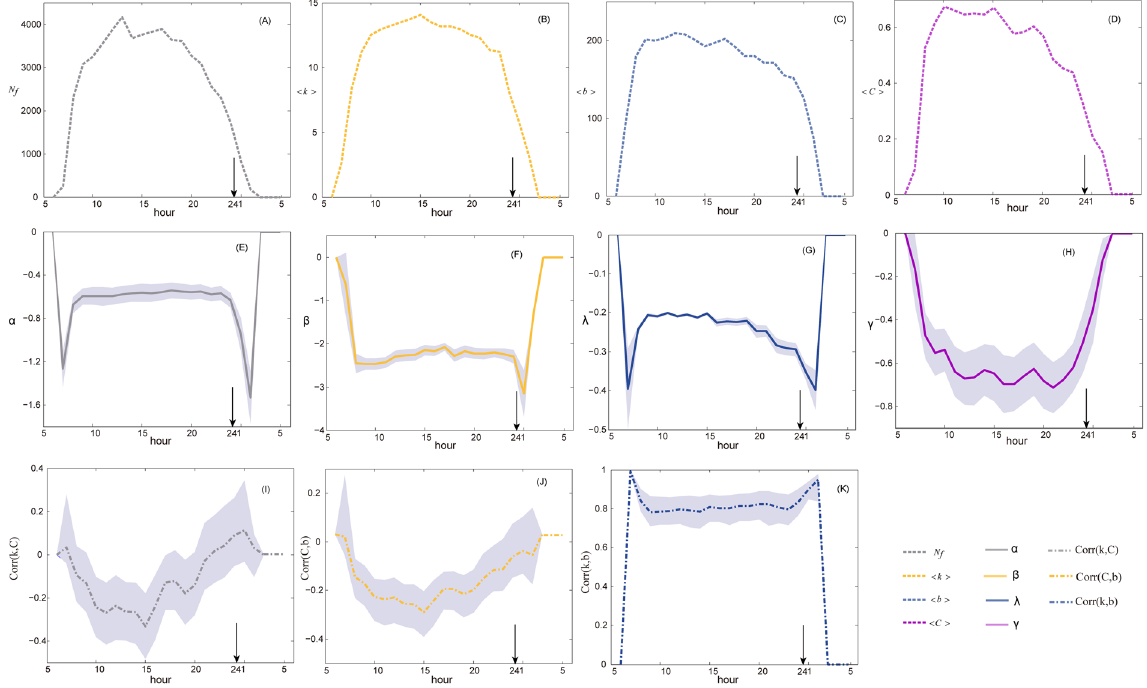
Figure 2. Temporal properties of the topology of CAN. 95% confidence interval are shown from ( E ) to ( K ). ( A ) Temporal property of the dynamics of flights. ( B – D ) Temporal properties of the averages of statistics. ( E – H ) Temporal properties of the distribution functions. λ and γ are parameters for the distributions of betweenness and the clustering coefficient, respectively, and α and β are parameters for the two-regime power law degree distribution. ( I – K ) Temporal properties of correlations between degree k , betweenness centrality b and clustering coefficient C . Corr ( x , y ) denotes the correlation between x and y